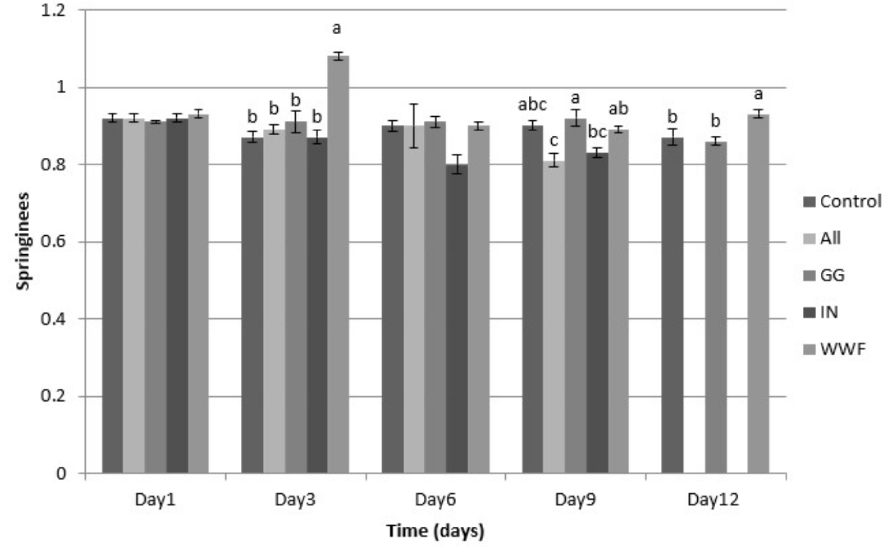
Figure 4. The impact of the added FI on Pita breads springiness. The a, b and c letters at each sampling time indicate statistically significant differences ( p < 0.05). Values are mean ± SEM of 6